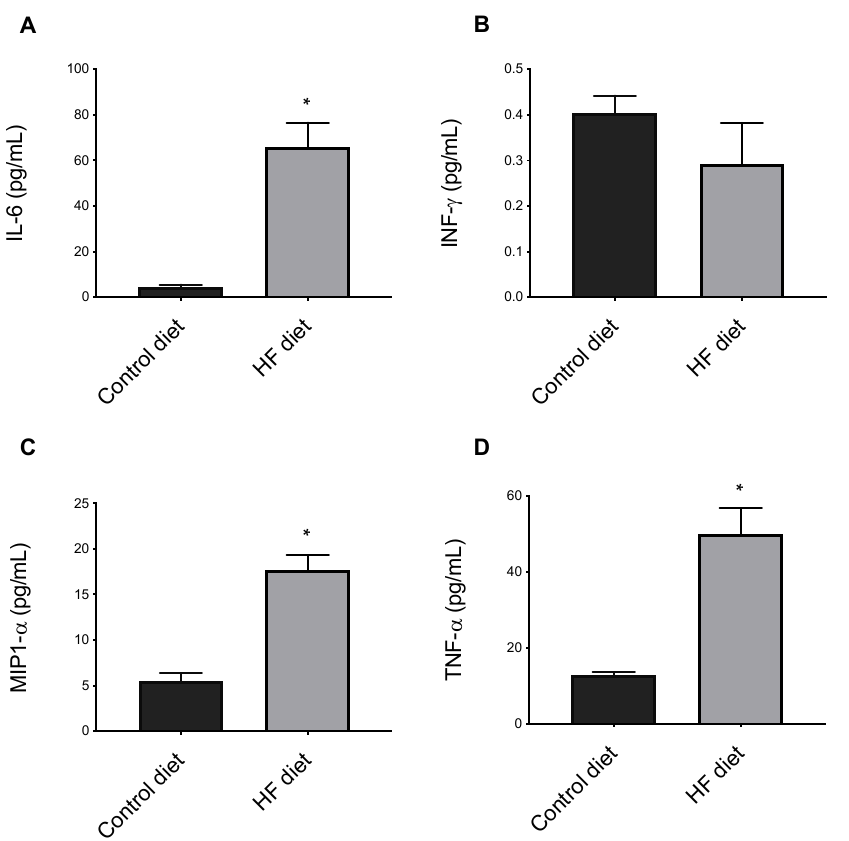
Figure 4. The effect of control and High-Fat (HF) diets on systemic inflammation. Interleukin 6, IL-6 ( A ); interferon gamma, INF- γ ( B ); macrophage inflammatory protein-1 alpha, MIP-1 α /CCL3 ( C ); tumor necrosis factor alpha, TNF- α ( D ). Data shown are the mean ± SEM (n = 4 per group). * p < 0.05 HF versus control.